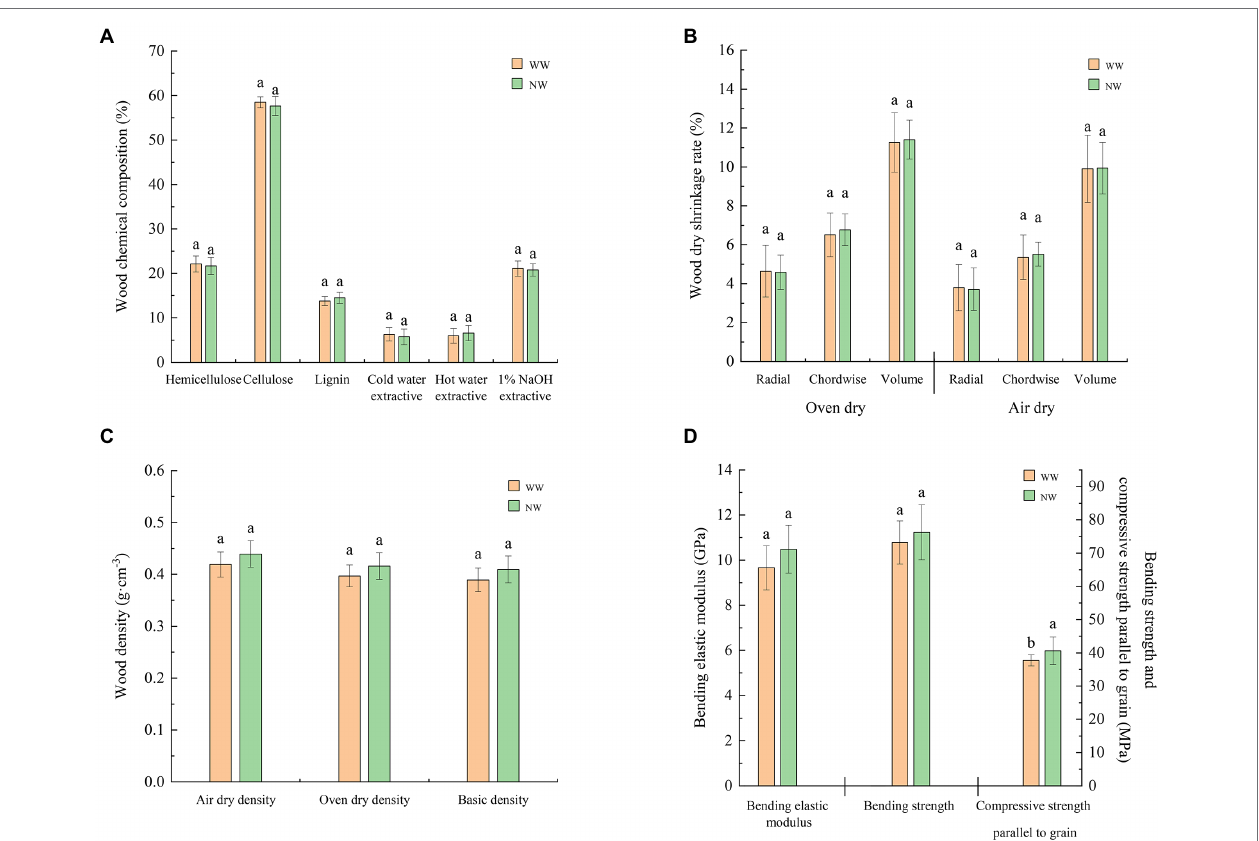
FIGURE 4 | Chemical properties and physical and mechanical indicators of the sapwood. (A) Chemical composition of the sapwood; (B) Dry shrinkage rate of the sapwood; (C) Density of the sapwood; and (D) Mechanical indicators of the sapwood. The letter represents a significant difference at the p < 0.05 level. WW and NW represent diseased and healthy trees,